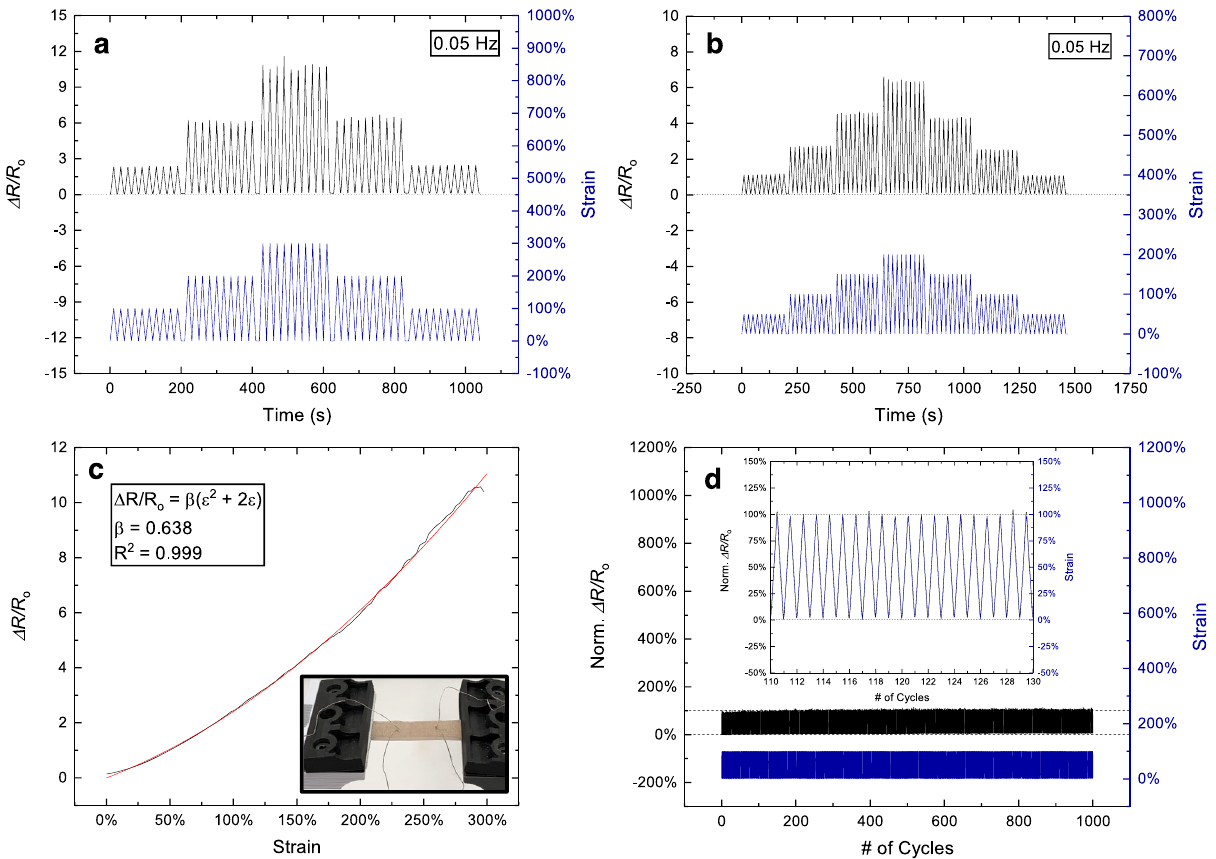
Fig. 3 Electromechanical characterization of strain sensors. Dynamic testing results ( a and b ) demonstrated a consistent electrical response up to 300% strain and no baseline drift for a frequency of 0.05 Hz. Horizontal dashed lines have been added to emphasize the lack of signal drift. An example of an extracted ramp test from a ( c ) revealed a parabolic relationship between the relative change in resistance and strain up to 300% strain. A picture of a strain sensor clamped in the electromechanical testing grips is shown in the inset of c. Cyclic testing up to 100% strain and 0.3 Hz resulted in minimal drift up to 1000 cycles ( d ), and normalized relative resistance results indicated excellent tracking of the amplitude and frequency of sensor actuation ( d ,